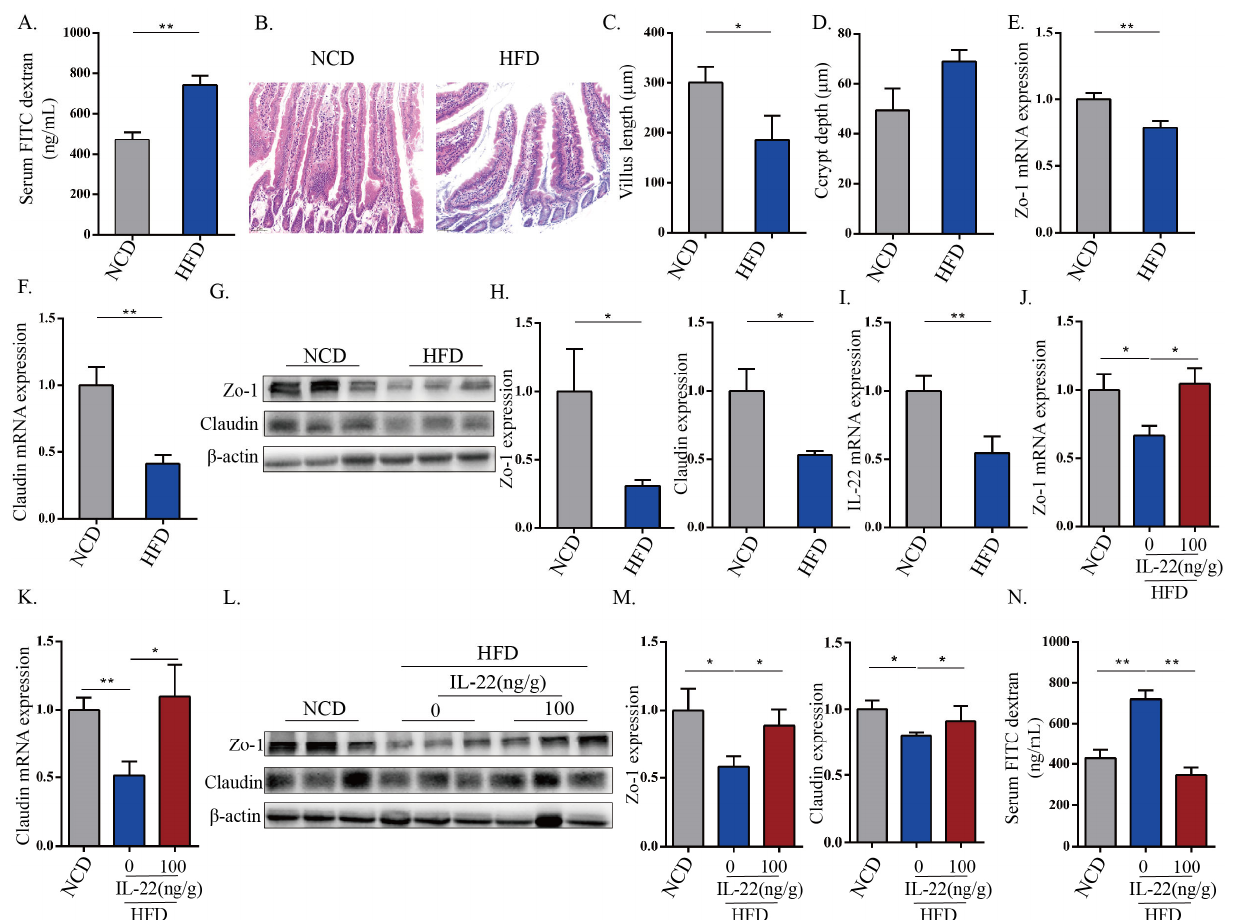
Figure 1. HFD ‐ induced intestinal epithelial barrier destruction was associated with the down ‐ ex ‐ pression of IL ‐ 22. ( A ) Serum FITC–dextran (4 kD) intensities of the indicated groups. ( B ) Hematox ‐ ylin and eosin (H&E) staining of the small intestinal tissues. Scale bars = 50 μ m. ( C ) Villus length. ( D ) Crypt depths of small intestinal tissues in the indicated group were calculated according to HE images. The mRNA expressions of Zo ‐ 1 ( E ) and claudin ( F ) in small intestine tissues. ( G , H ) The protein expression levels of ZO ‐ 1 and claudin in small intestine tissues of the indicated mice were calculated via Western blotting (3 samples/group). β‐ actin was used as a loading control. ( I ) Evalu ‐ ation of the relative mRNA expression of IL ‐ 22 in small intestine tissues of the indicated mice were calculated using qPCR. ( J – M ) The mRNA and protein expression levels of ZO ‐ 1 and claudin in small intestine tissues were detected after treatment with IL ‐ 22. ( N ) The intestinal barrier permeability was calculated via serum FITC–dextran (4 kD) intensities after treatment with IL ‐ 22. Mean ± SEM are plotted. * p < 0.05, ** p < 0.01, as determined by one ‐ way ANOVA followed by the Tukey–Kramer post hoc test.